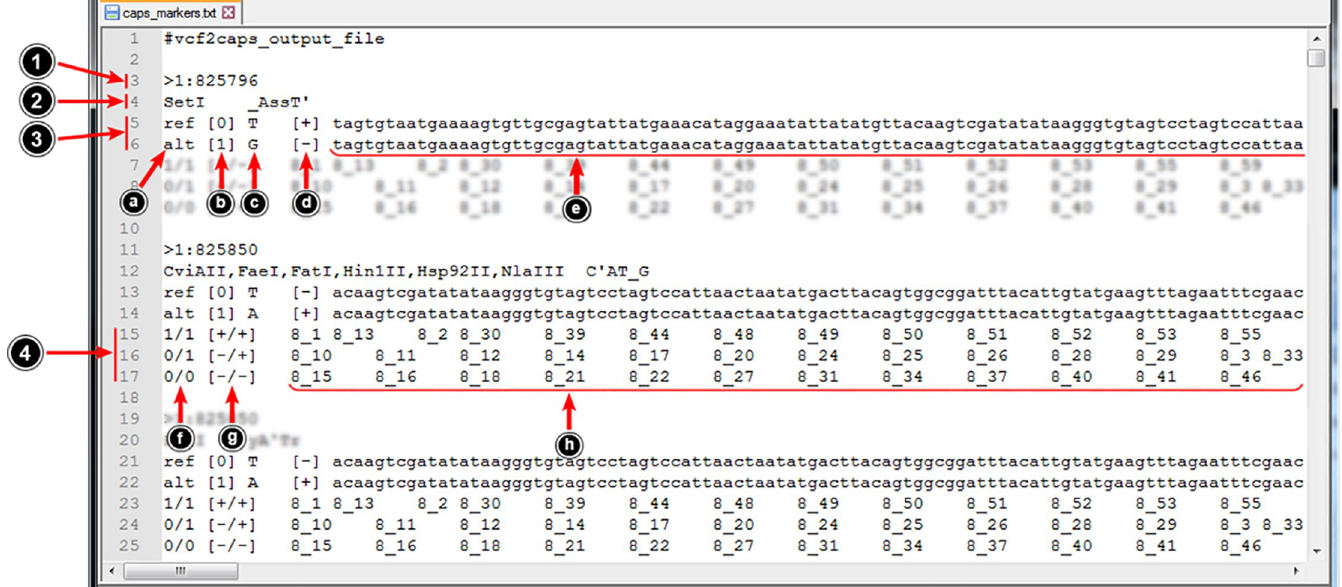
Fig 4. Fragment from an exemplary VCF2CAPS output file–its elements are marked with arrows and described in the text.